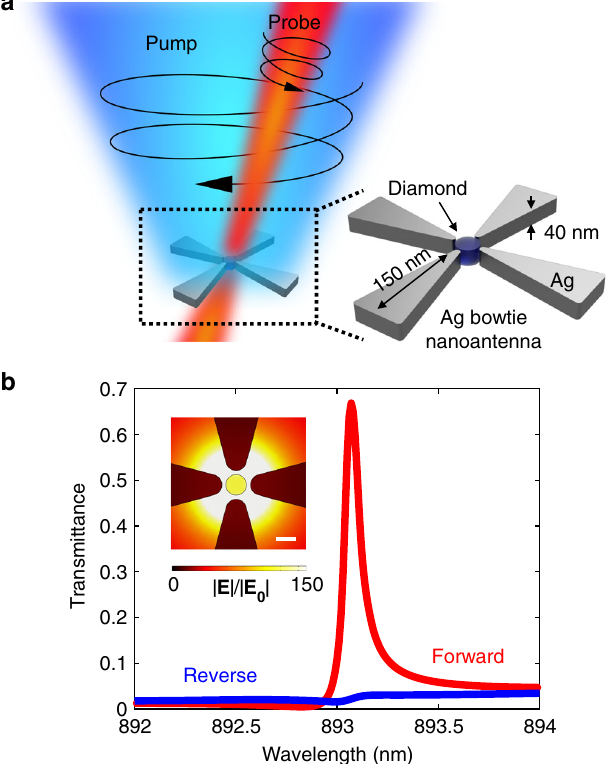
Fig. 4 Simulating behavior of nonreciprocal plasmonic resonator. a Schematic of rotationally symmetric, diamond loaded bow-tie nanoantenna. b One-way transparency in plasmonic resonance for circularly polarized pump with intensity of 700 mW µ m − 2 . Inset shows fi eld enhancement within diamond loaded gap. Surrounding medium has n = 1. Scale bar is 4 nm